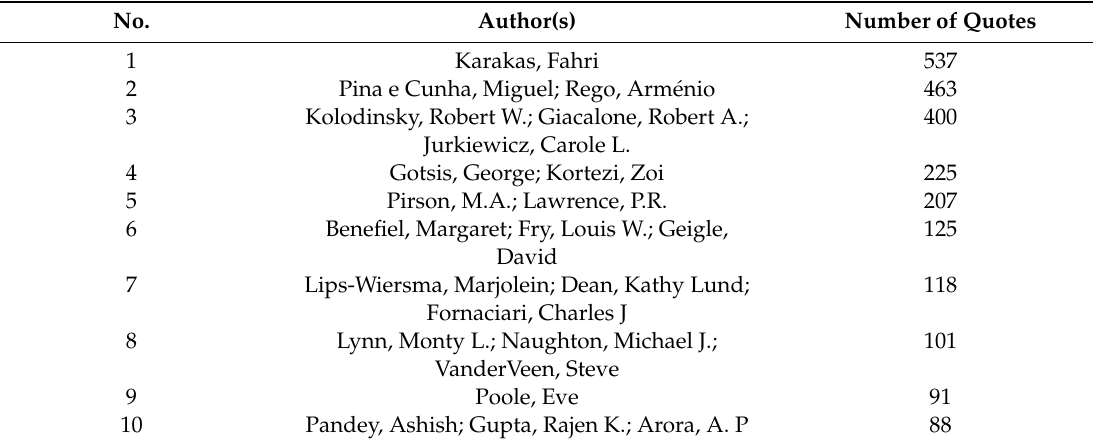
Table 3. Top 10 cited authors.